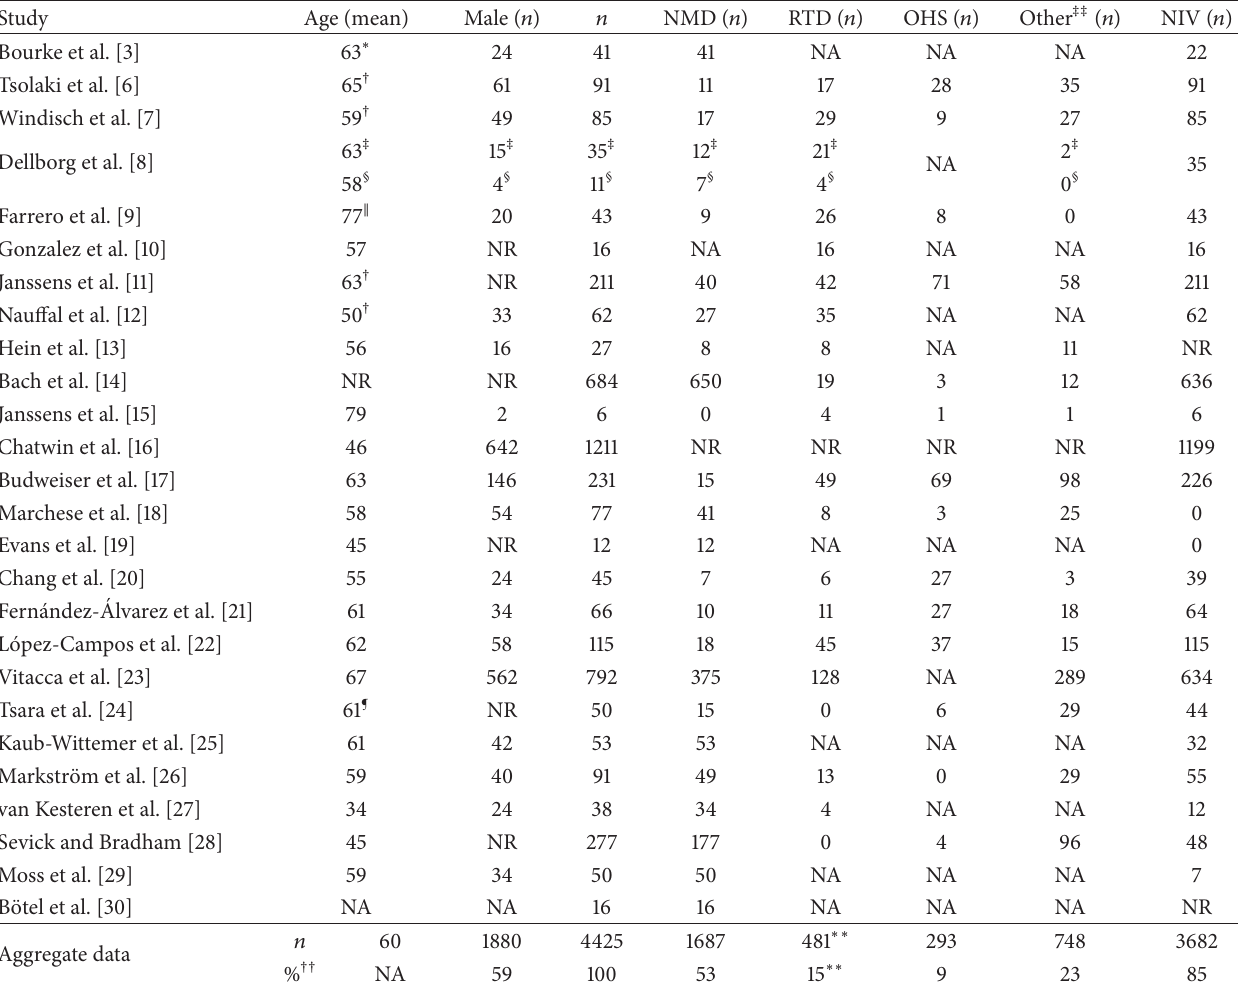
Table 2: Patient